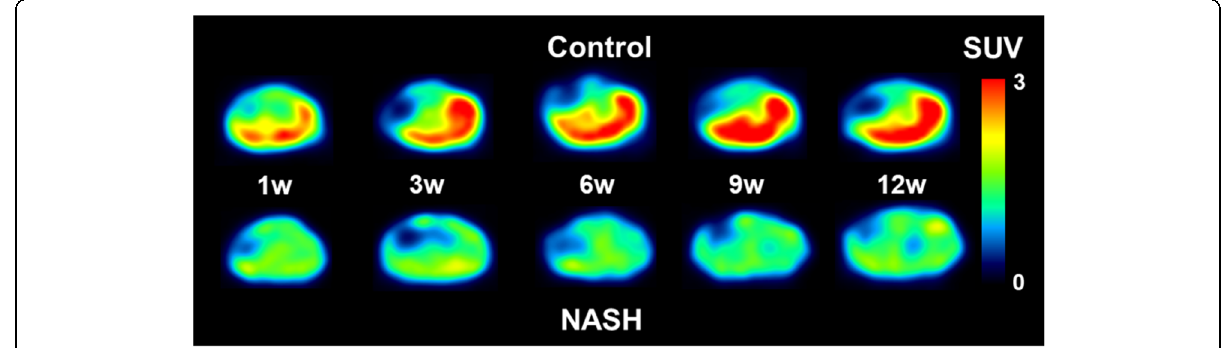
Fig. 1 PET images of the liver of mice fed choline-deficient, L -amino acid defined, high-fat diet and of age-matched control mice. PET scanning was conducted for 90 min following injection of mice with 18 F-BCPP-BF. PET data from 20 to 40 min were reconstructed to obtain images that were used to calculate standard uptake value